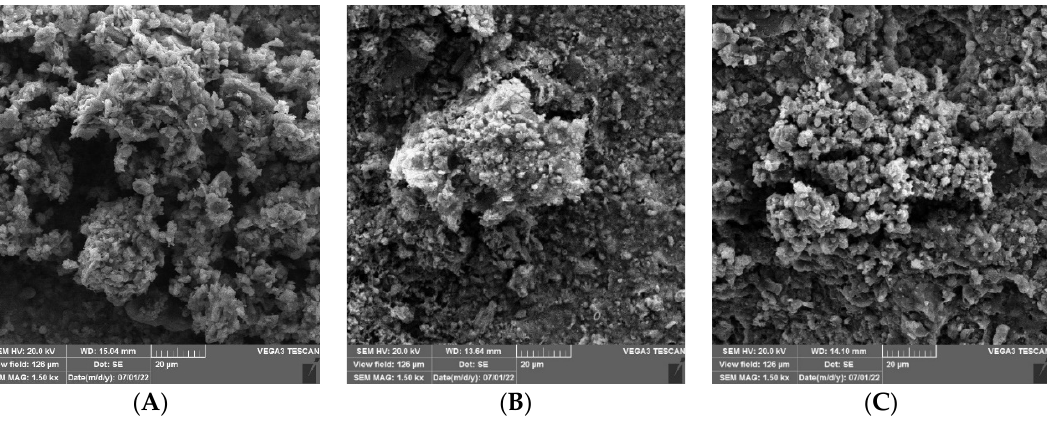
Figure 5. FESEM images of ceramic membranes M ( A ), M/SiC ( B ), and M/SiC/Fe20 ( C ) after filtra- tion .